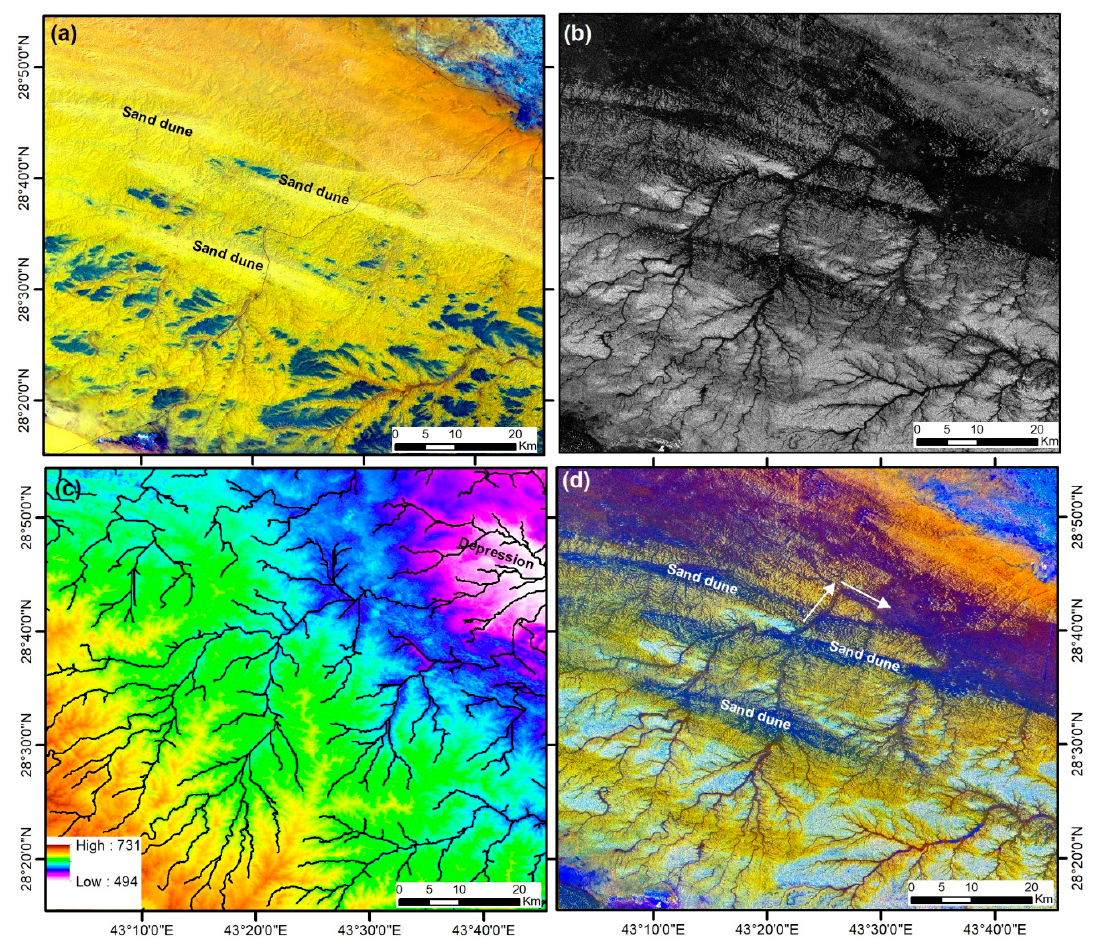
Figure 6f for the proposed lake.